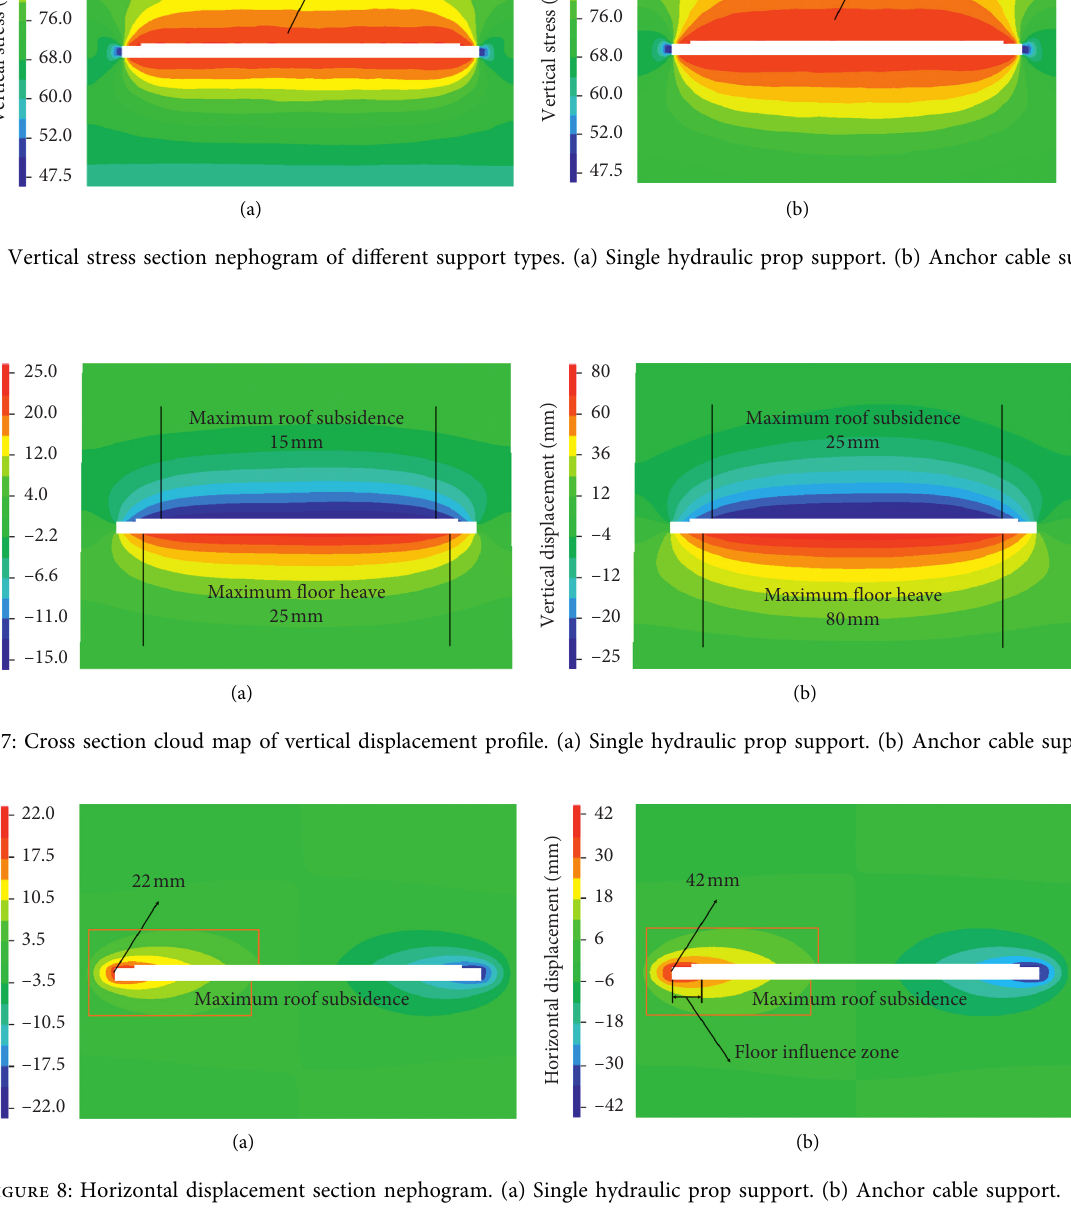
Figure 8: Horizontal displacement section nephogram. (a) Single hydraulic prop support. (b) Anchor cable support.